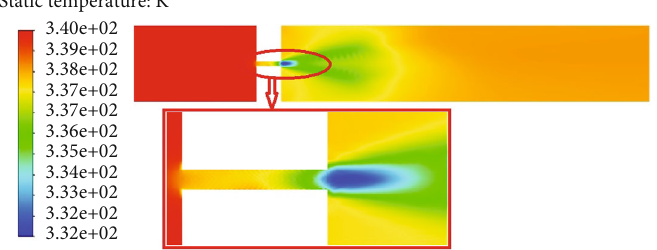
Figure 15: Cloud diagram and curve of total temperature of fl ow fi eld in